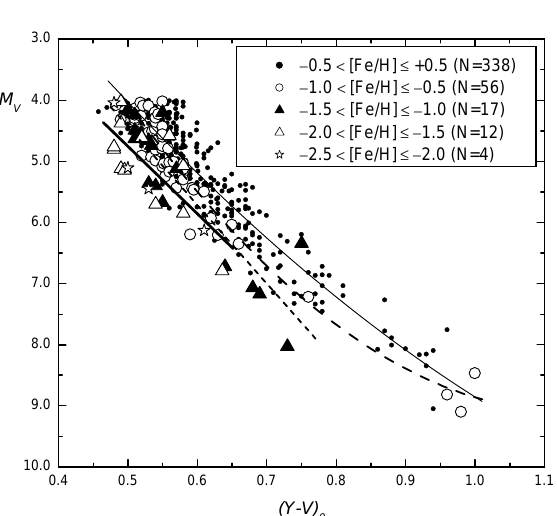
Fig. 3. HR diagram for the sample dwarfs and subdwarfs. The cali- bration curves are drawn for [Fe/H] intervals –0.5 to +0.5 (thin solid line), –1.0 to –0.5 (dashed line), –1.5 to –1.0 (short dashed line), and –2.0 to –1.5 (thick solid line).